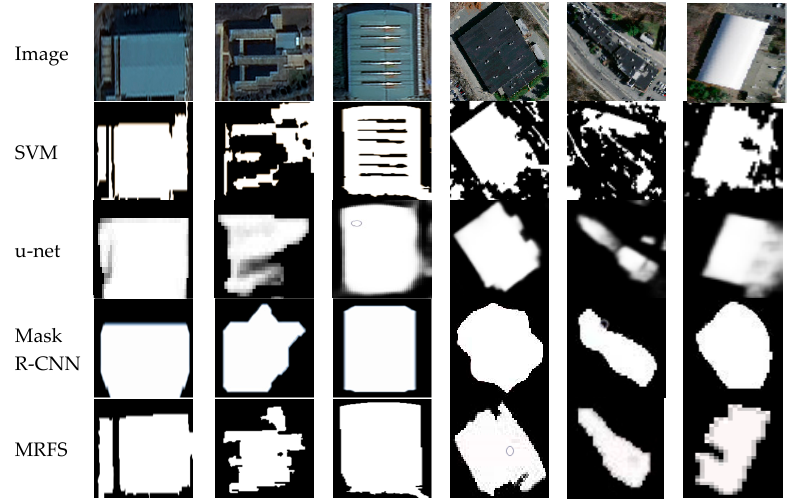
Figure 13. Comparison of single building detection maps.